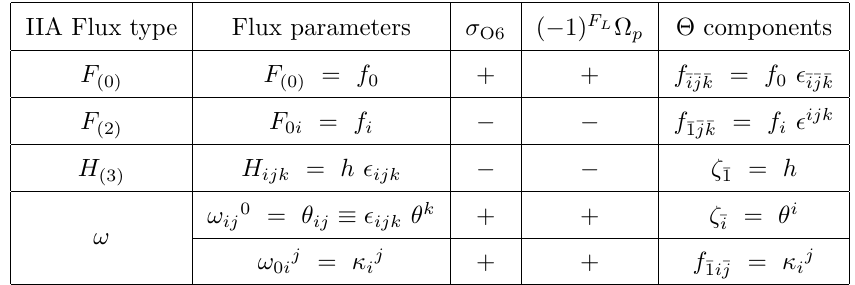
Table 1 . The explicit dictionary between type IIA (cid:13)uxes consistent with the O6 involution and deformation parameters of N = (1 ; 1) supergravity in six dimensions.